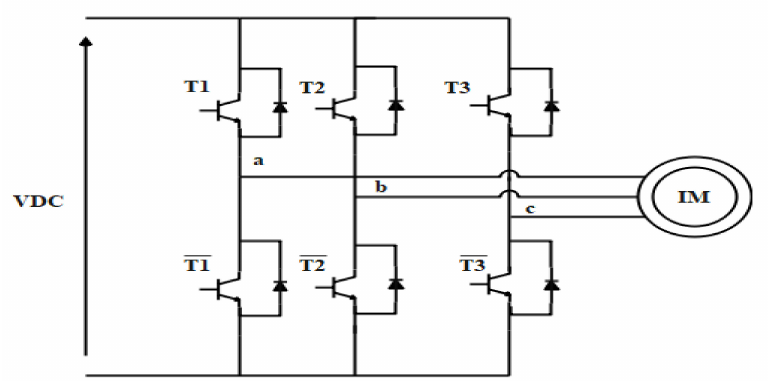
Figure 4. Three-phase inverter. Si = 1 if Ti is switched on, else Si = 0 i = (1, 2,